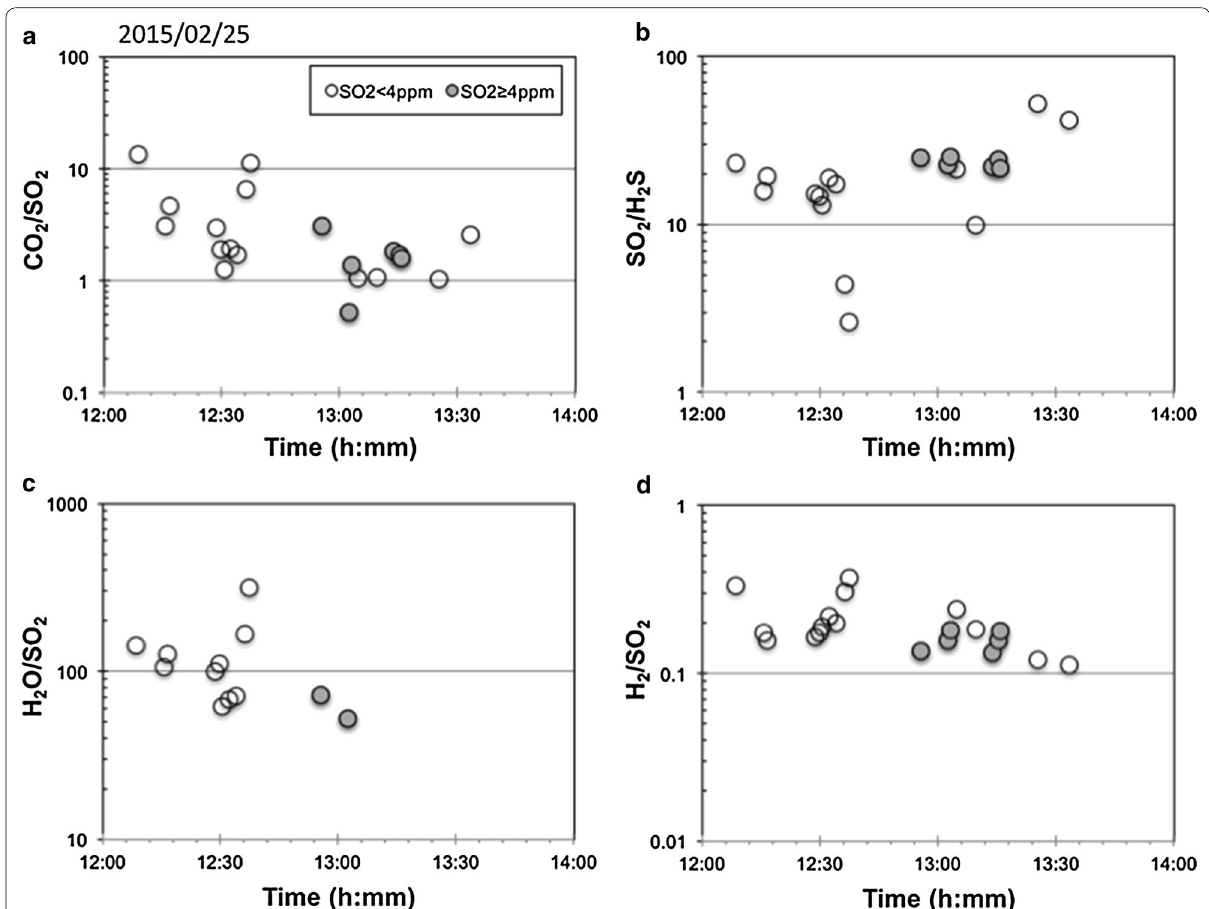
Fig. 5 A short-term variation of gas concentration molar ratios on 25 February 2015. a CO 2 /SO 2 molar ratio, b H 2 O/SO 2 molar ratio, c SO 2 /H 2 S molar ratio, and d H 2 /SO 2 molar ratio. Grey circles show ratios obtained for high concentration peaks of SO 2 concentration peaks of SO 2 > 4